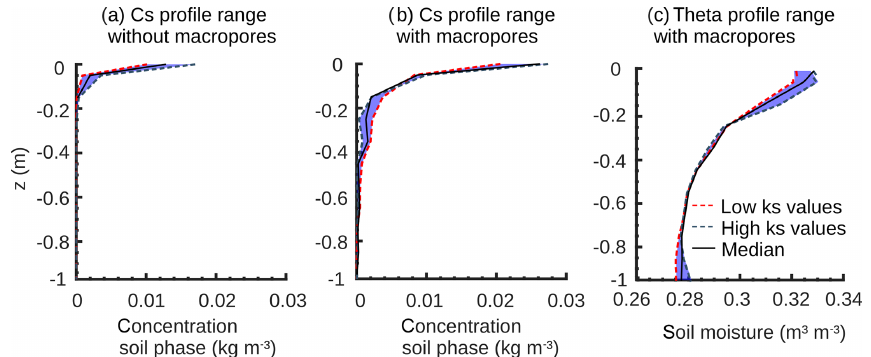
Figure 7. Final simulated bromide concentration (Cs) and soil moisture (theta) profiles of the soil matrix (a) without and (b, c) with macro- pores at different k s values. The blue area shows the possible range of simulated profiles with different k s values.